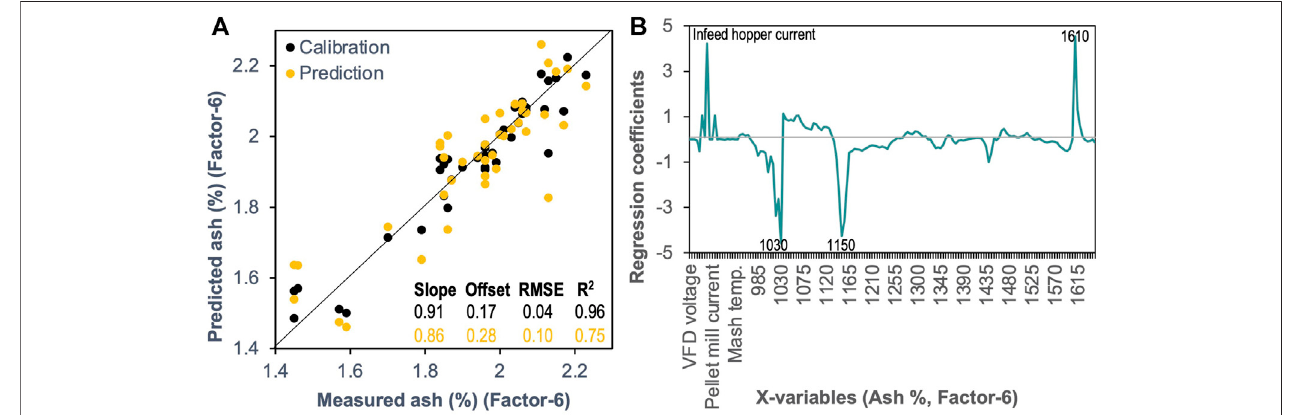
FIGURE 5 | (A) Scatter plots of prediction results for ash content (%) of the blended pellets by a PLSR model trained with NIR principal component scores (in 950 – 1,650 nmregion)andpelletingprocessdata; (B) Regressioncoef fi cientsassociatedwiththePLSRmodel.Thepelletblendswerecomposedof6-in.(152.4 mm)or 2-in. (50.8 mm) southern yellow pine (SYP) tops and switchgrass (SG), ground in a hammer mill fi tted with a 6.35 mm screen and mixed at either 60:40 or 50:50